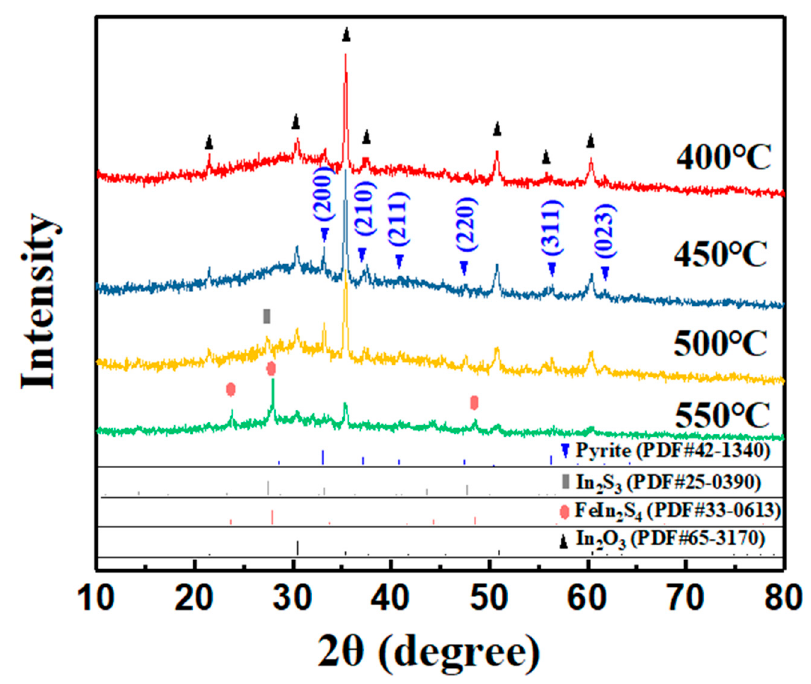
Figure 4. XRD patterns of films obtained by sulfurization at different temperatures (film thickness is about 200 nm).